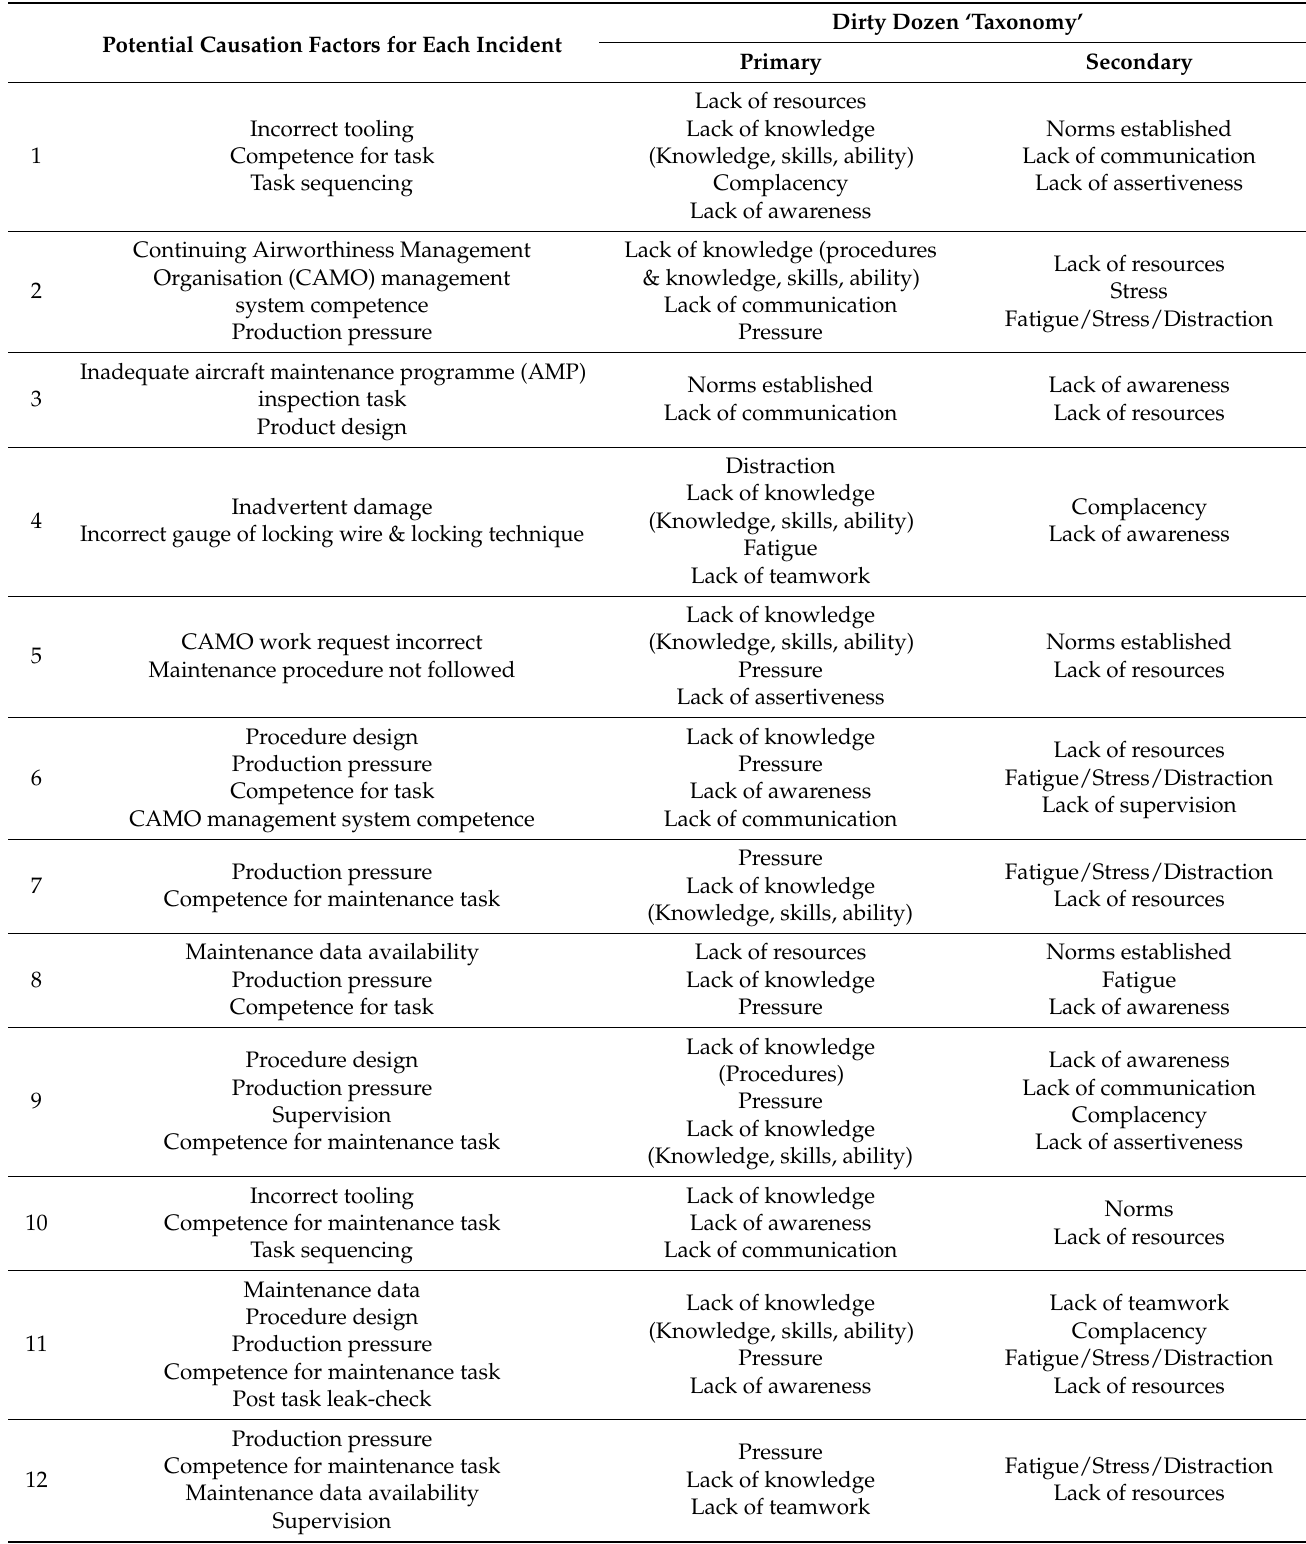
Table 1. Results of the analysis of 15 incidents and mapping against the ‘Dirty